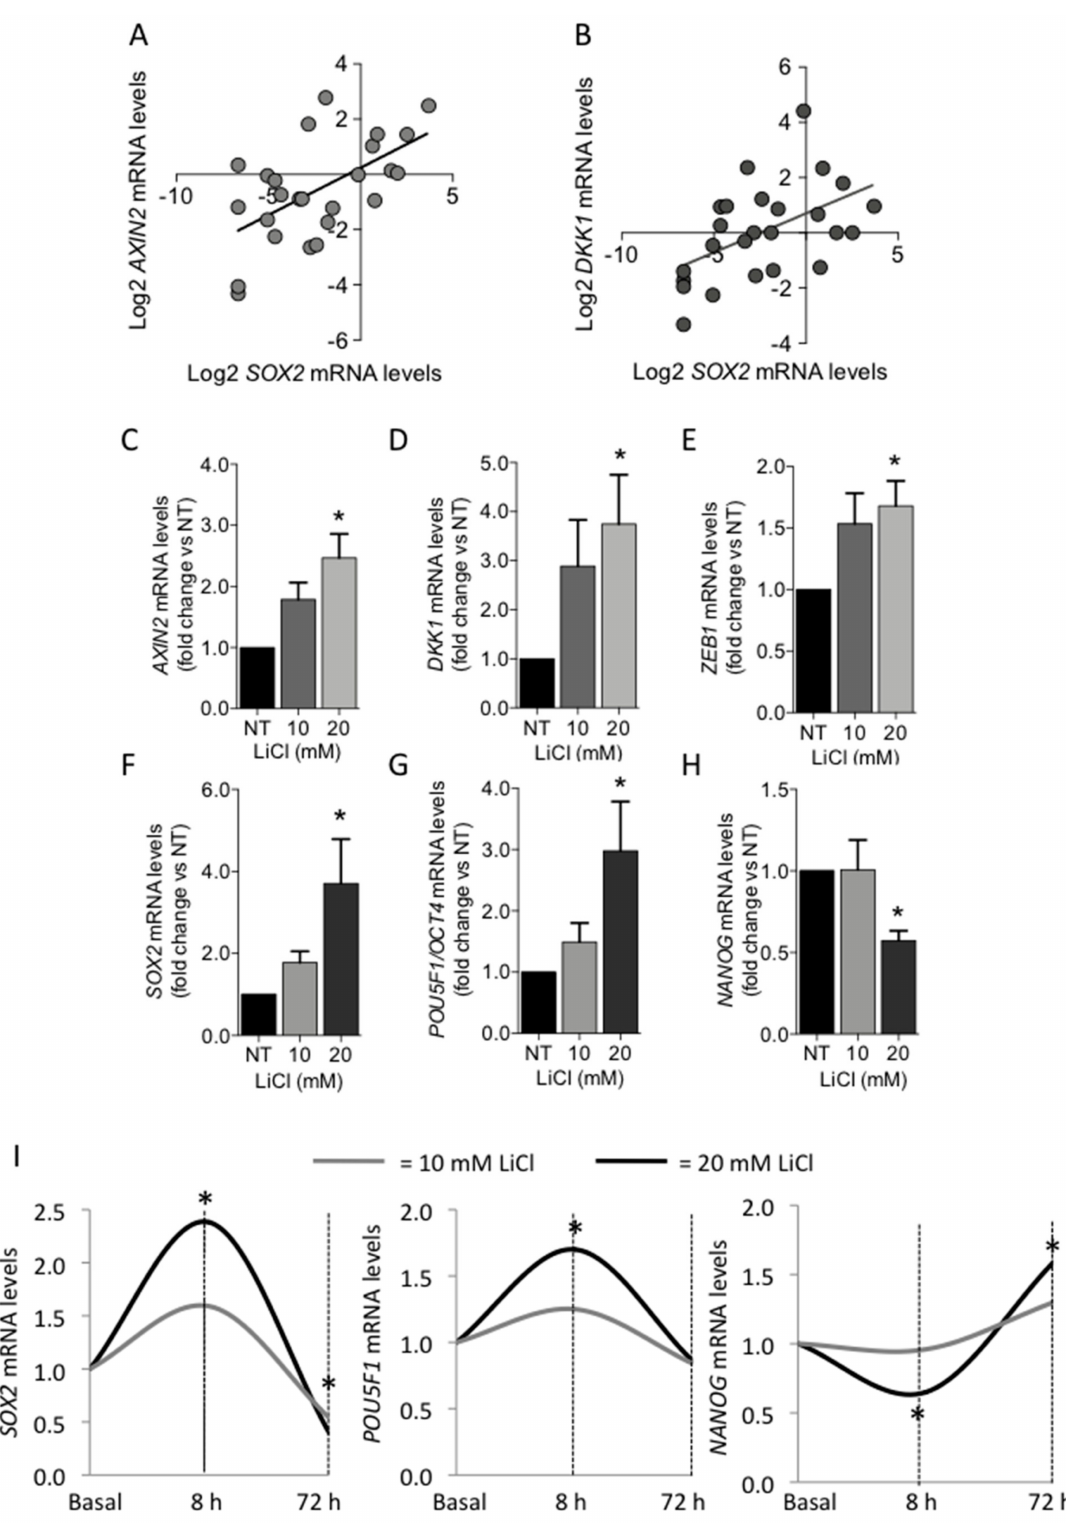
Figure 3. Effect of WNT/ β -catenin activation on core stem genes expression in PAds-derived cells. ( A ) Positive correlation between SOX2 and AXIN2 mRNA levels. ( B ) Positive correlation between SOX2 and DKK1 mRNA levels; data are log2 transformed. Effects of LiCl treatment (10–20 mM) for 8 h in PAds-derived cells on AXIN2 ( C ), DKK1 ( D ), ZEB1 ( E ), SOX2 ( F ), POU5F1/OCT4 ( G ), and NANOG ( H ) mRNA levels. ( I ) Effects of LiCl treatment (light grey lines, 10 mM; black lines, 20 mM) in PAds-derived cells on SOX2 , POU5F1/OCT4 , and NANOG mRNA levels after 8 and 72 h; * p < 0.05 by one-way ANOVA adjusted for multiple